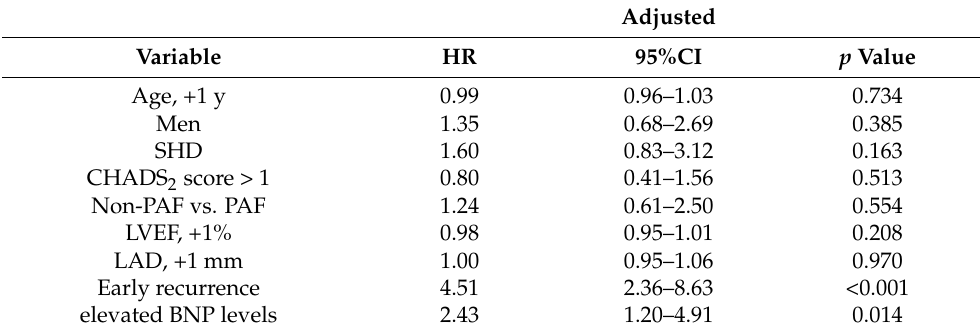
Figure 2. A Kaplan–Meier curve showing the arrhythmia recurrence rate for patients with (green) and without (blue) elevated BNP (brain natriuretic peptide) levels. Table 4. Factors associated with arrhythmia recurrence after AF ablation with adjusted